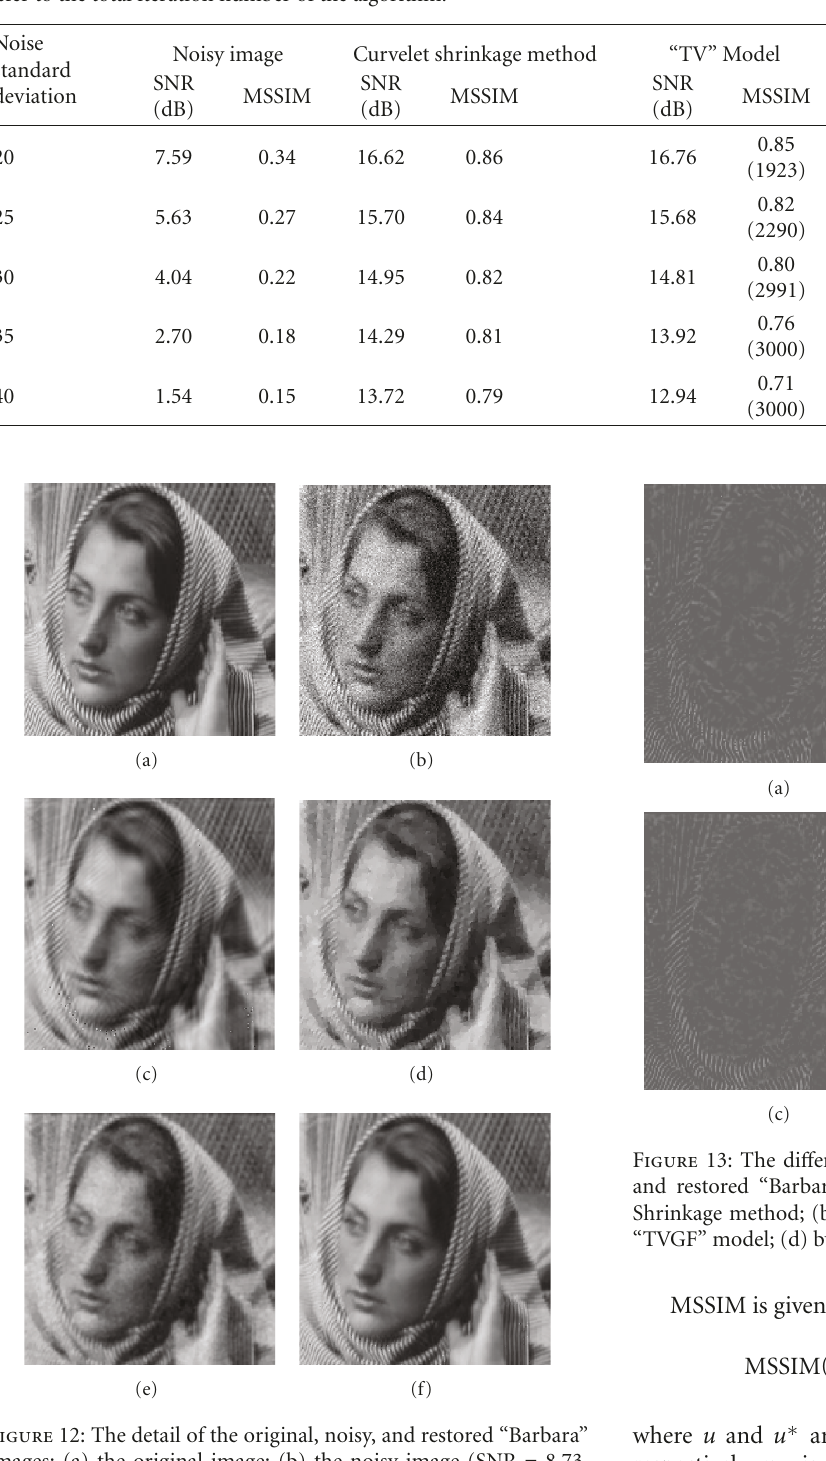
Table 1: The SNR, MSSIM of the restored “Lena” images by using four models. The numbers in the bracket under the “MSSIM” column refer to the total iteration number of the algorithm.